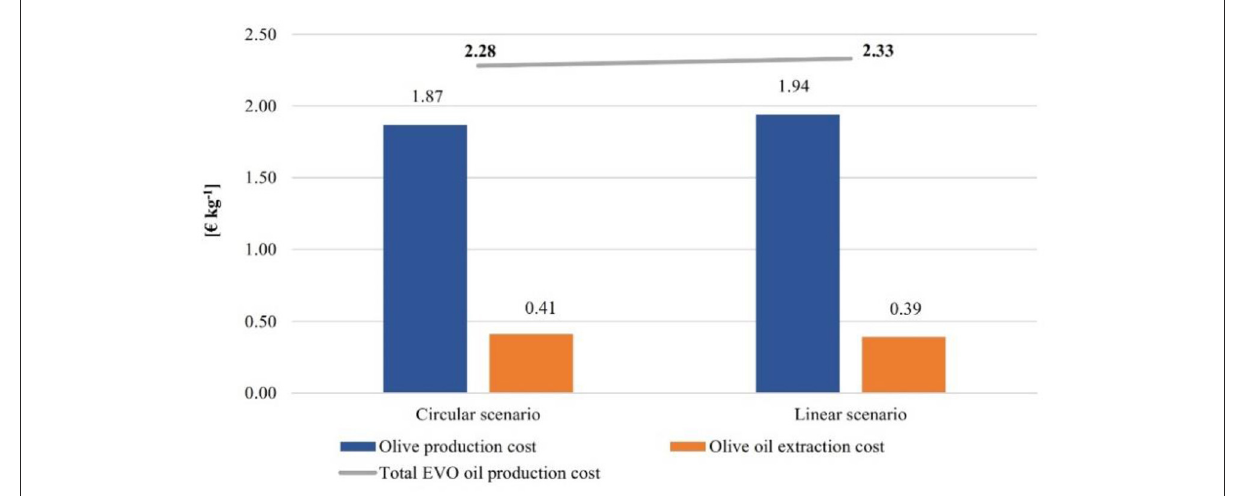
FIGURE3 Total costs of EVO oil production per scenario (Source: Authors’ elaboration).